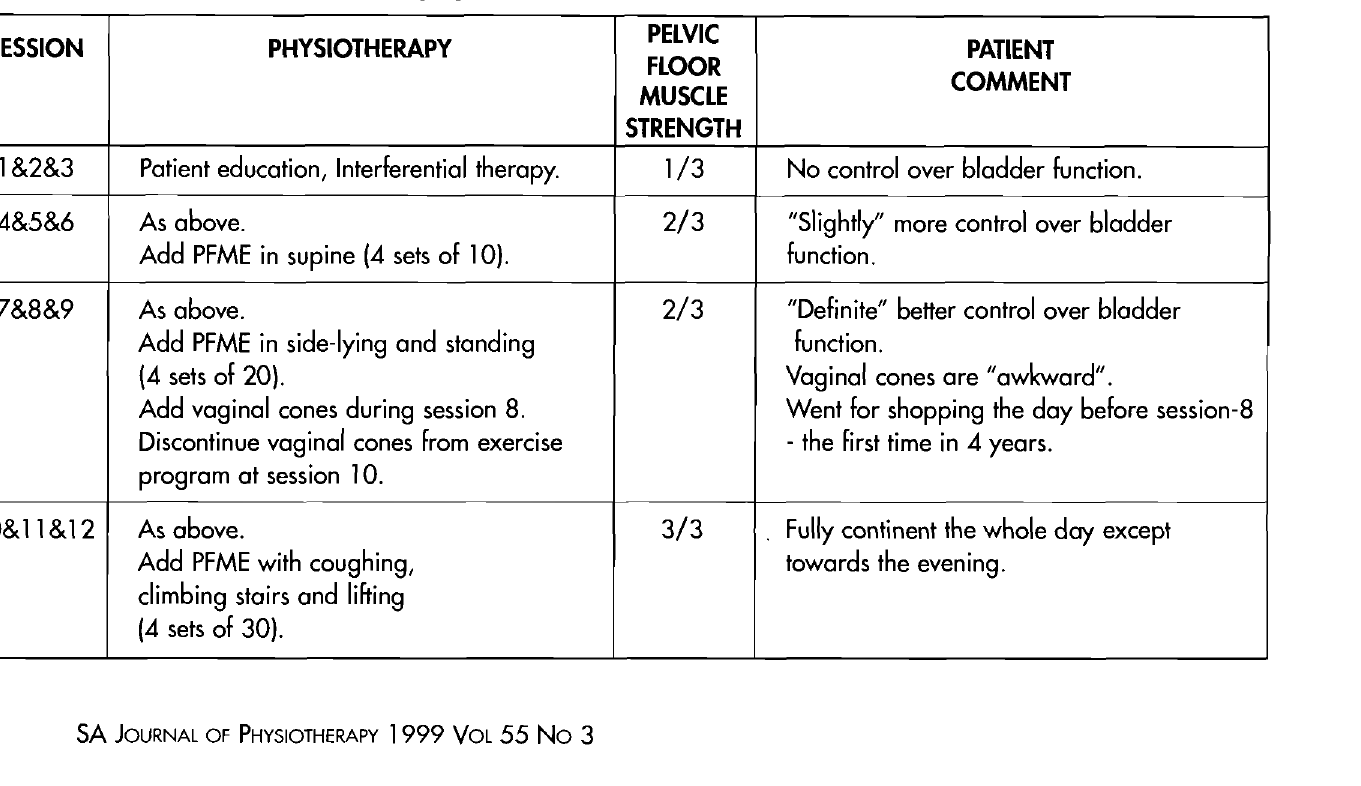
TABLE 1: SUBJECTIVE AND OBJECTIVE IMPROVEMENT IN PELVIC FLOOR MUSCLE STRENGTH AS EVALUATED DURING THE 12 PHYSIOTHERAPY